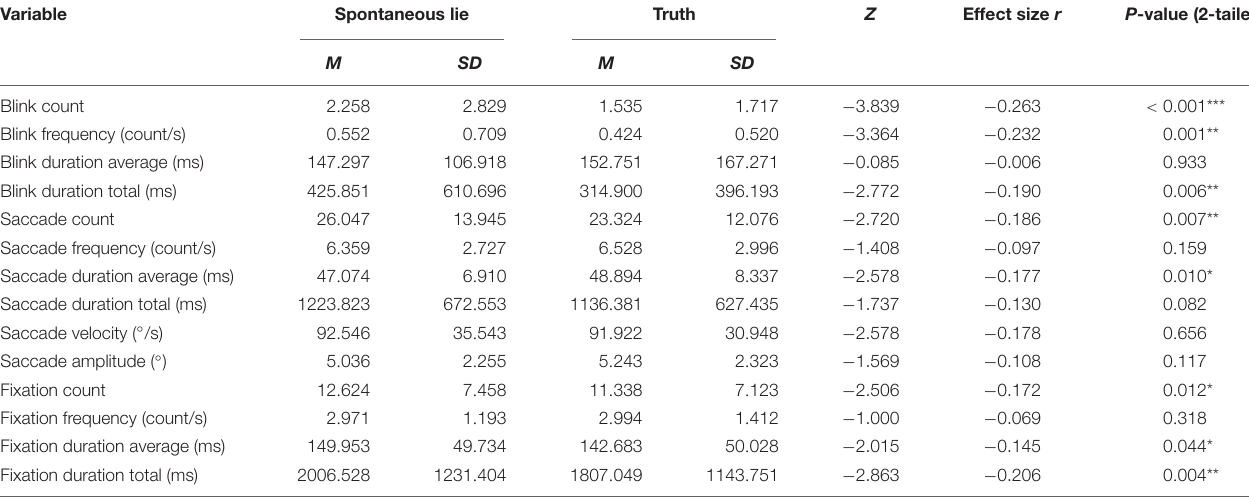
TABLE 2 | The analysis of blink behaviors, saccade behaviors and fixation behaviors in Study 1.